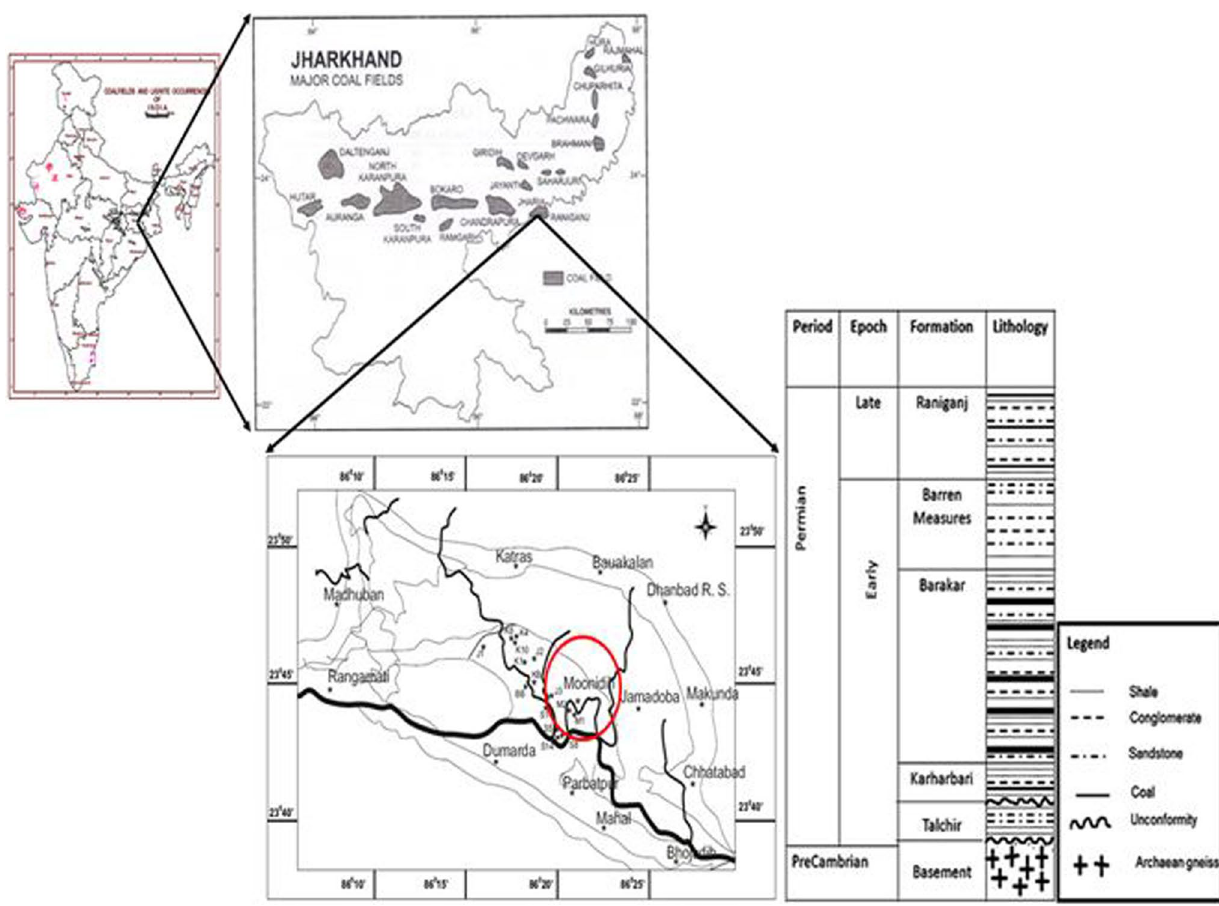
Fig. 1 Geological map and lithology of the Jharia Coalfield showing Moonidih coal block (Modified after Ghosh et al. 2014; BCCL 2012)